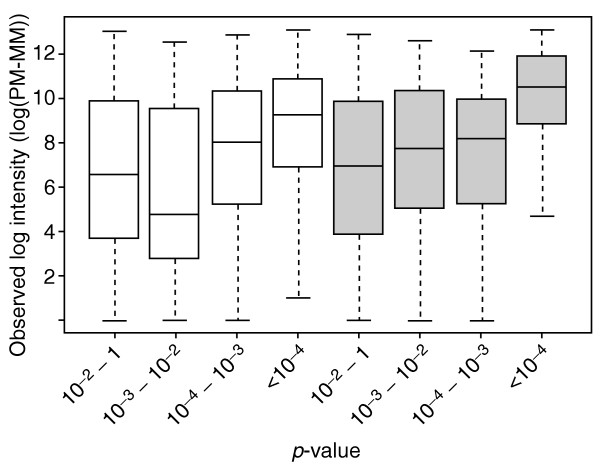
Low p-value PolII and PolIIa enrichments are biased towards higher mRNA levels. The plot depicts the observed intensity from Affymetrix U133 Plus 2 chips compared with different p-values of PolII (white) and PolIIa (gray). Some genes with no significant PolII enrichment show high levels of observed intensity.